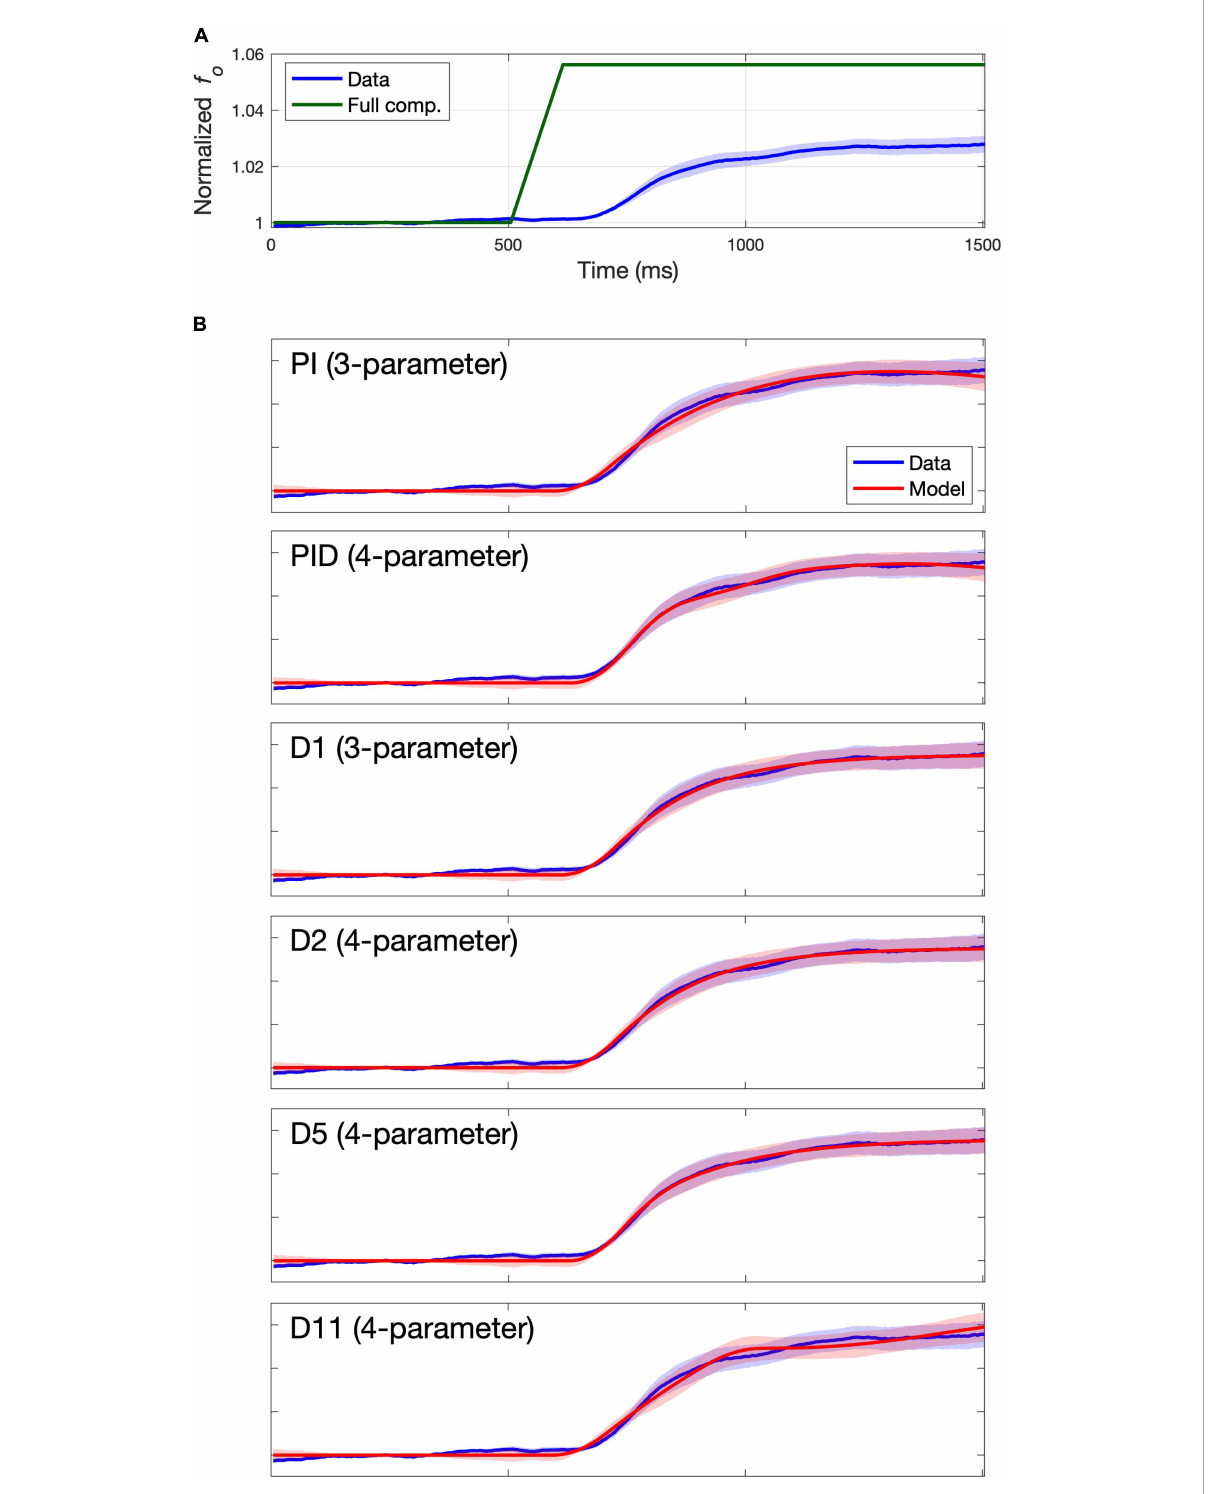
FIGURE2 Group mean data and model fits for Study 1. Group mean data and standard error of the mean are shown with a blue line and shading. (A) Group mean data shown relative to full compensation in green. Full compensation is the inverse of the perturbation magnitude and illustrates what 100% compensation would look like. (B) Group mean data shown relative to model fit (red line) and standard error of the model fit (red shading) for models providing best fits to the group mean